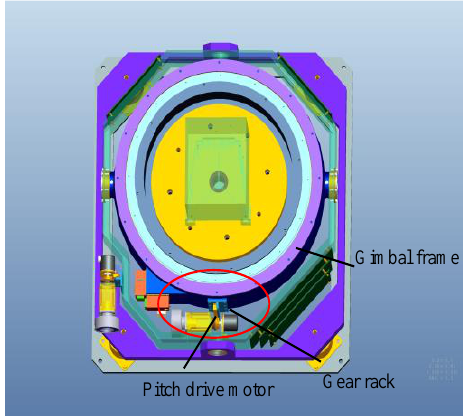
Figure 4. The transmission structure of gimbal frame.